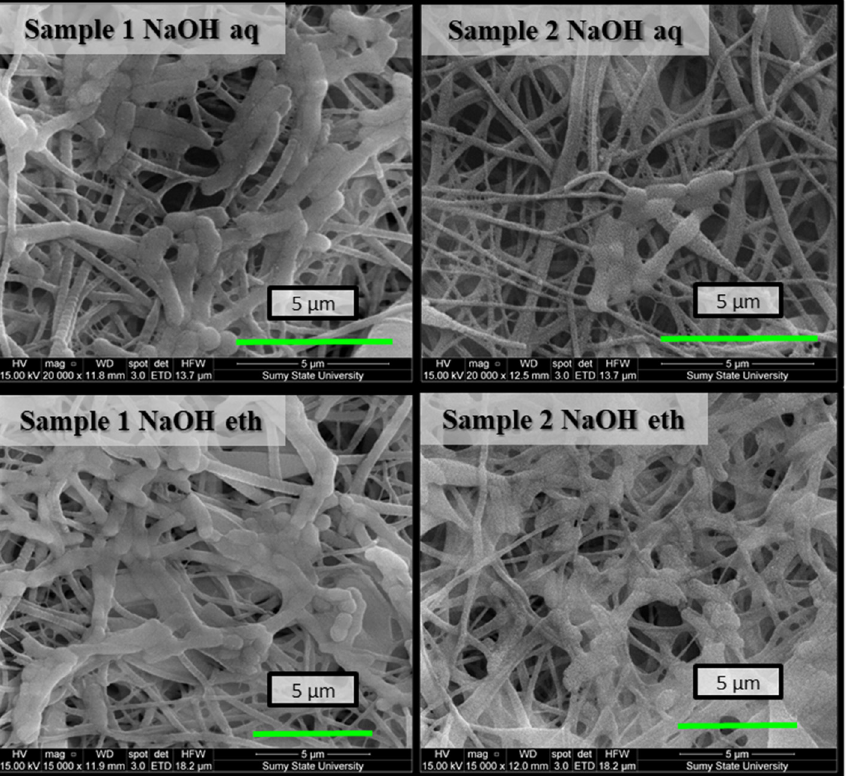
Figure 7. SEM images of bacterial biofilms on the surfaces of electrospun nanofibrous membranes after 8 h co-cultivation in the bacterial suspension of E. coli .